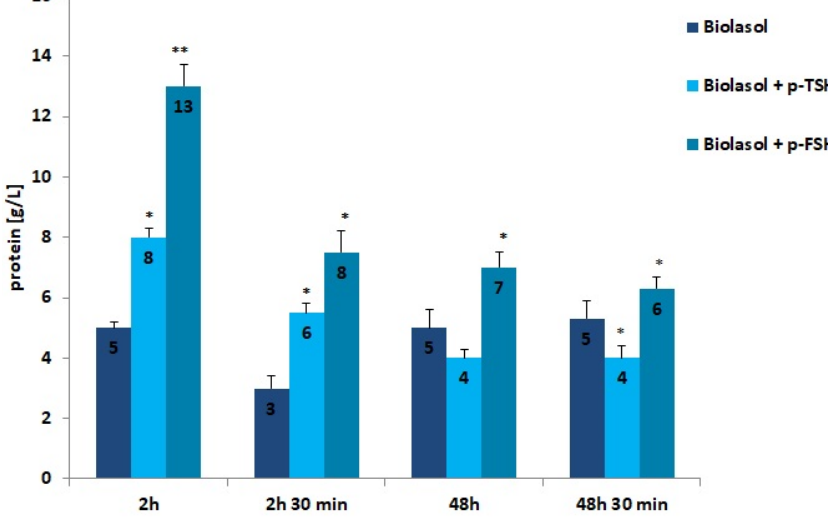
Figure 6. Protein concentrations in the collected perfusates. The values are expressed as mean ± SEM.